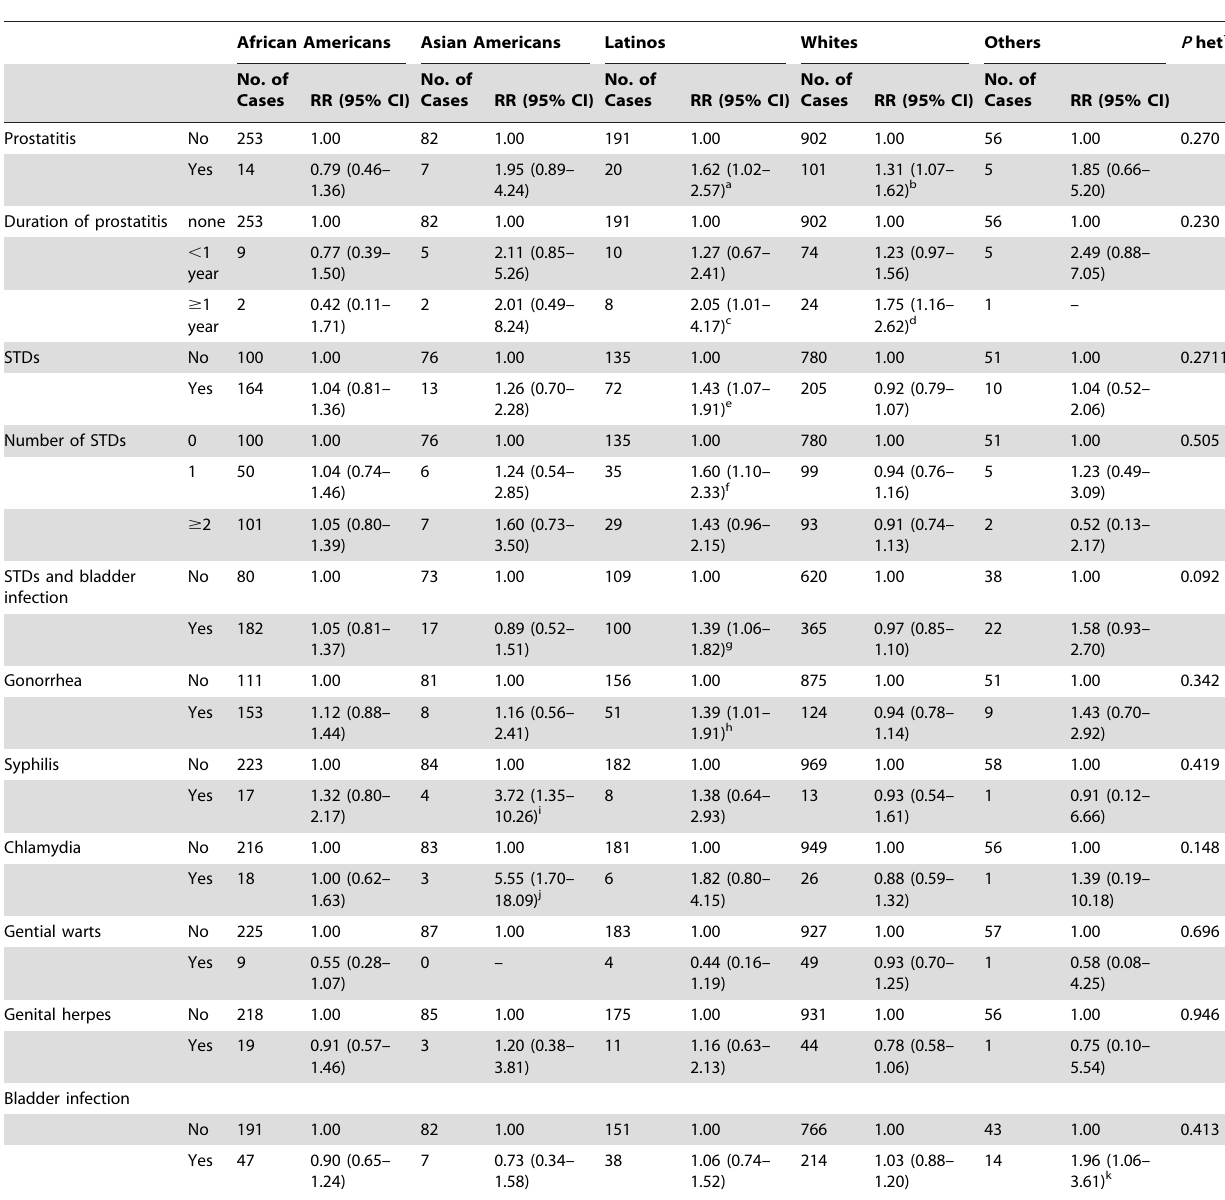
Table 4. Multivariate relative risks and 95% CIs of prostate cancer associated with prostatitis and STD history by racial/ethnic group, California Men’s Health Study,